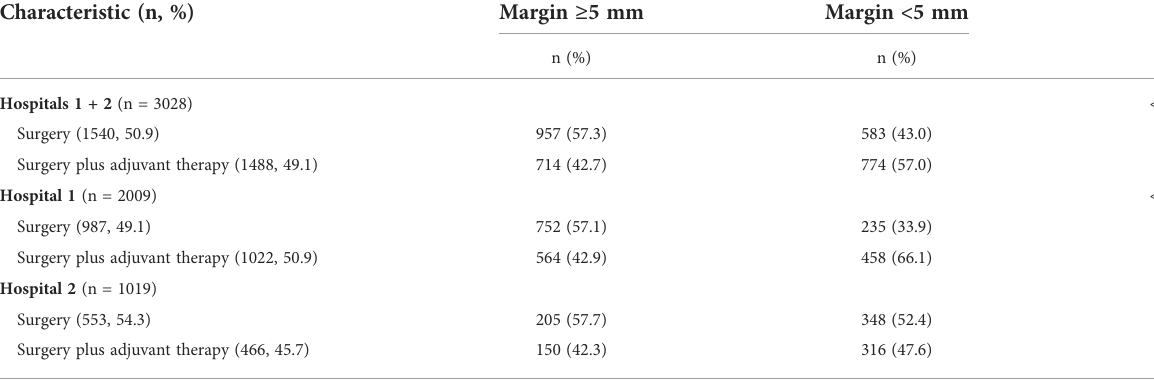
TABLE 7 Analysis of margin status in relation to treatment modalities implemented in Hospital 1 and Hospital 2.